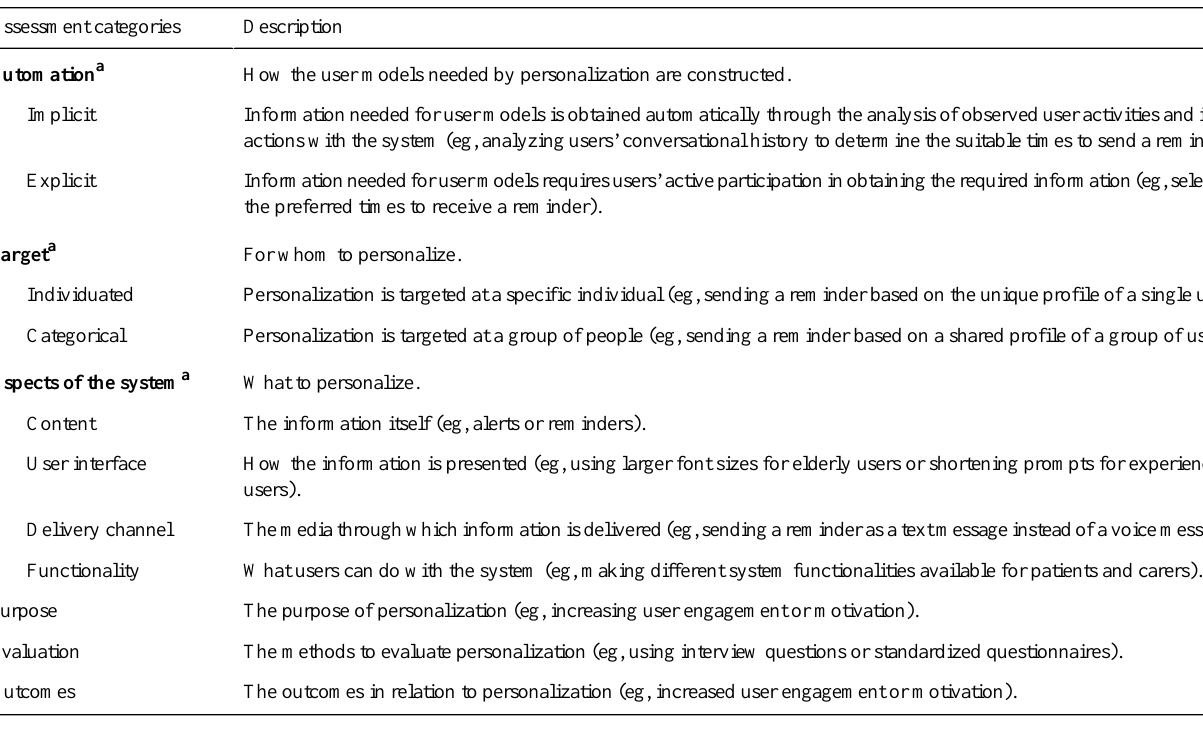
Table 1. An assessment scheme for